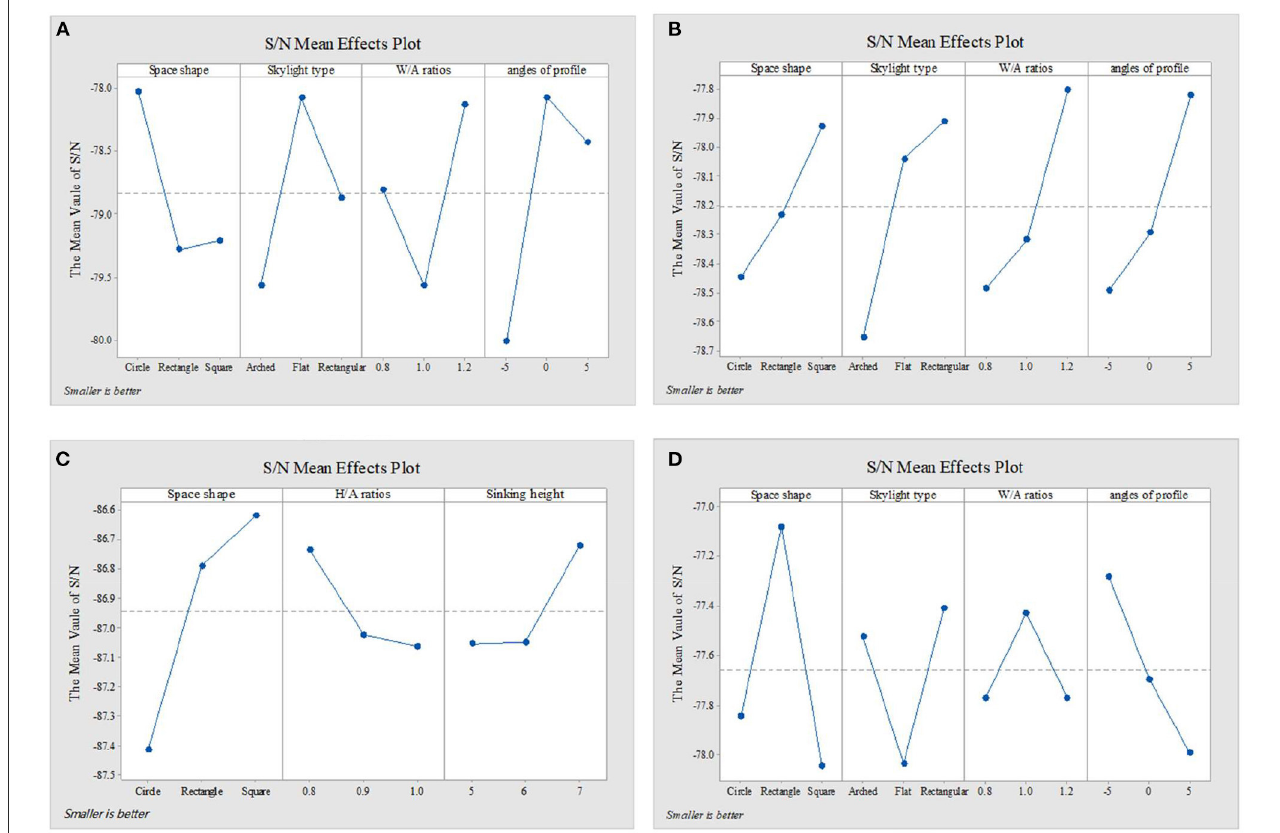
FIGURE10 Thermal environment response values for (A) TUAI, (B) TCAI, (C) TCSI, and (D) THAI. Image source: self-drawn by the